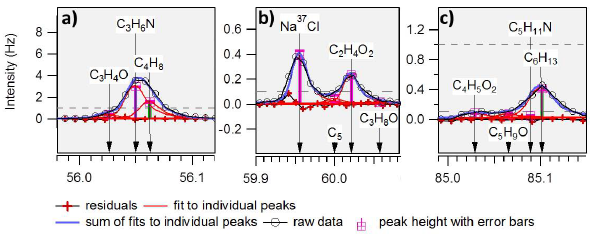
Fig. 15. Selected m/z where carbohydrate ion fragments are ex- pected.